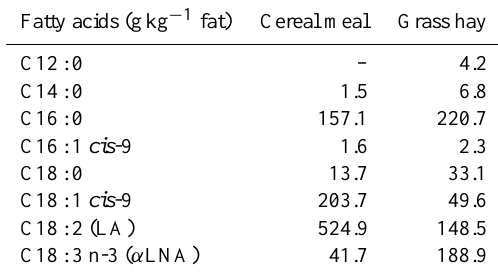
Table 2. The fatty acid profile of feeds used in nutrition of examined ewes. Fatty acids (gkg − 1 fat) Cereal meal Grass